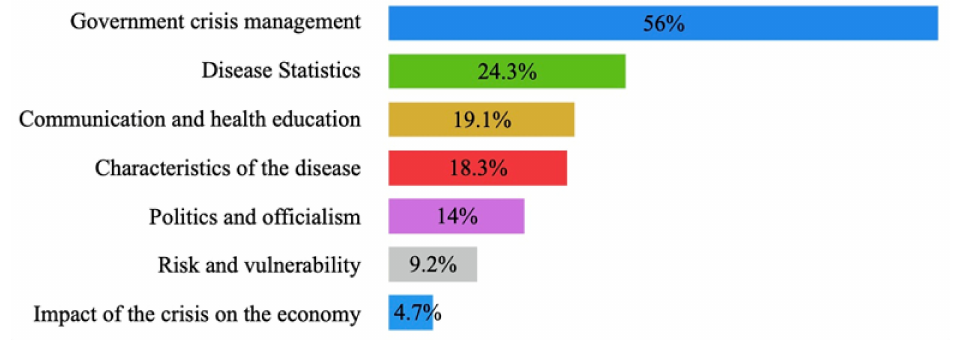
Figure 1. Percentages of the topics of the journalists’